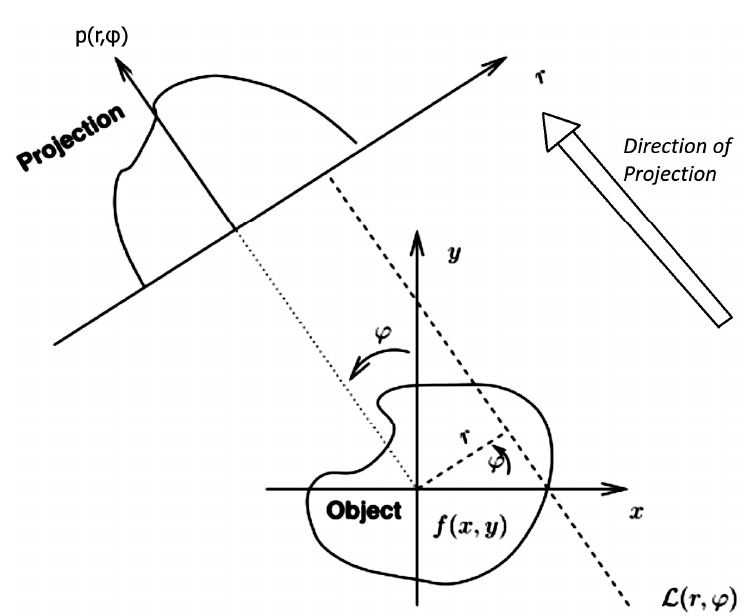
Figure 2. Schematic representation of projection in two dimensions (2D) when performing the Radon transform.